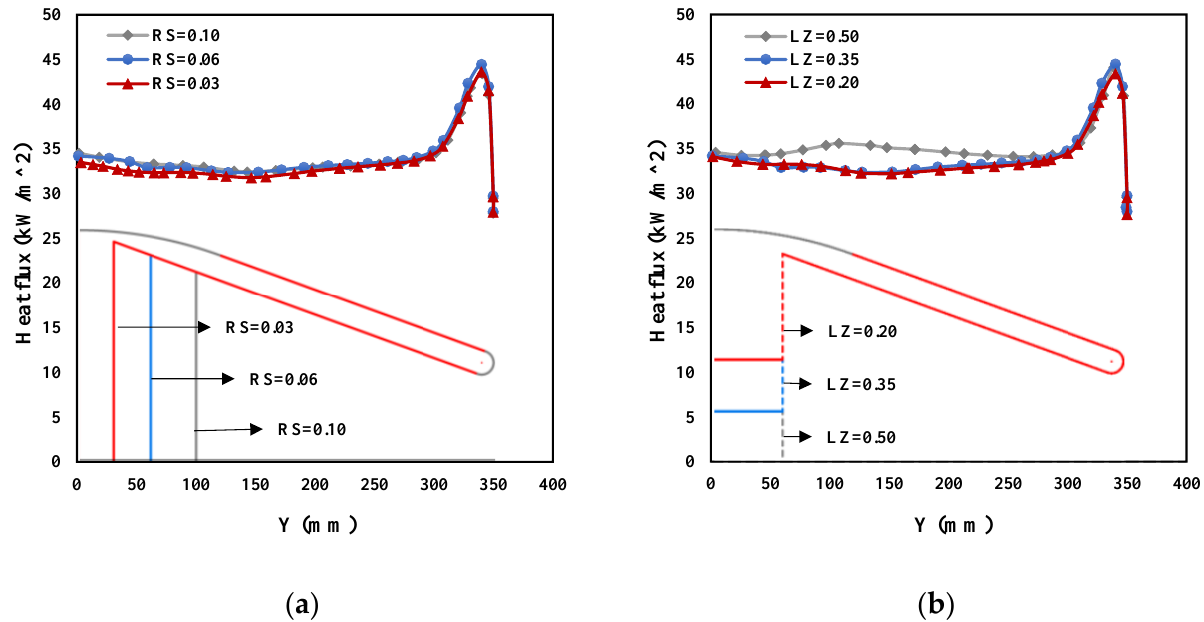
Figure 15. Heat flux distribution of case 0-0, case 5-1 to case 6-2: ( a ) R S is changed; ( b ) L Z is changed.